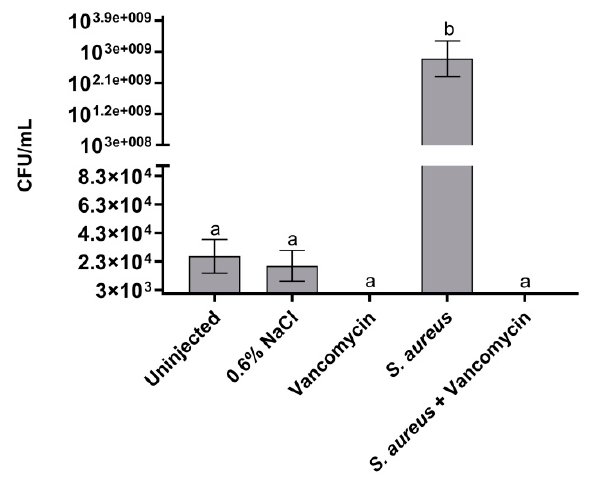
Figure 4. Analysis of bacterial load in control larvae (uninjected larvae and larvae injected only with physiological solution) and in healthy and infected larvae treated and untreated with vancomycin (8.75 μ g/g body weight). Values represent mean ± s.e.m. Different letters indicate statistically significant differences among treatments ( p < 0.05).